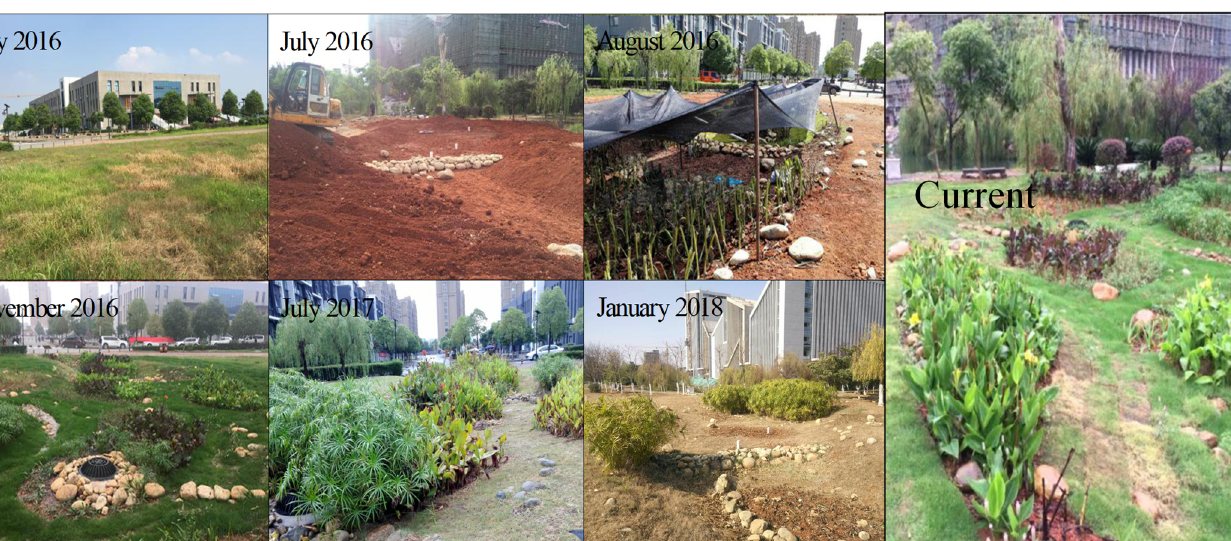
Figure 3. Plane layout of the rain garden. Based on the design layout of the rain garden, a variety of plant communities were set up in the rain garden and the surroundings. Plants were an important part for the rain garden, which could retain water and certain pollutants. Native plants were the best choice in most cases since they were adapted for local environmental conditions and re- quired less care. Additionally, plants should be able to tolerate periodic inundation. The principles of economic benefit, local conditions and diversity were followed and major plant species were chosen, such as Canna generalis , Lythrumsalicaria , Cyperus alternifolius , Irispseudacorus and Miscanthus sinensiswere [26]. 2.6. Inlet and Cross-Section Design of the Rain Garden Inlet design is a critical part of a rain garden. When the road elevation is higher than the surface of the rain garden, road runoff would flow into the rain garden and be tested. For the Nanchang site, the minimum elevation of the catchment area was 19.0 m, where catch-basins were available to collect road runoff. After the transformation (Figure 4), when the rainfall was light, road runoff could be completely collected by the rain garden. 15m 2 64 m 2 203 m 2 Over well